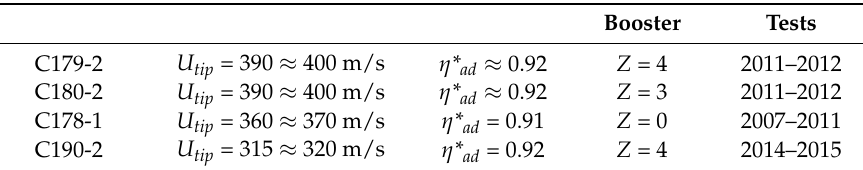
Table 1. Family of fan model prototypes.